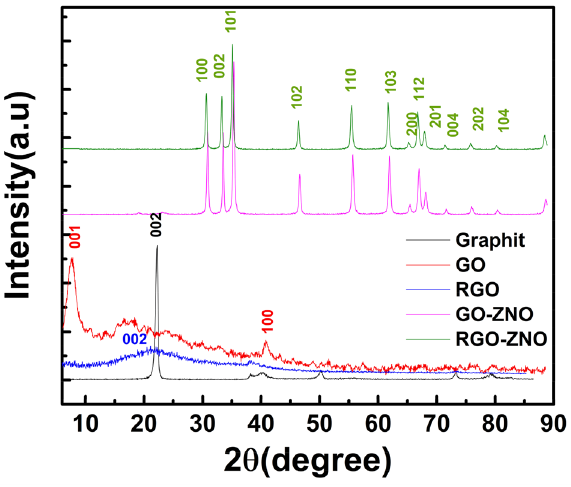
Figure 1. XRD patterns of Graphite, GO, RGO, GO-ZnO, and RGO-ZnO